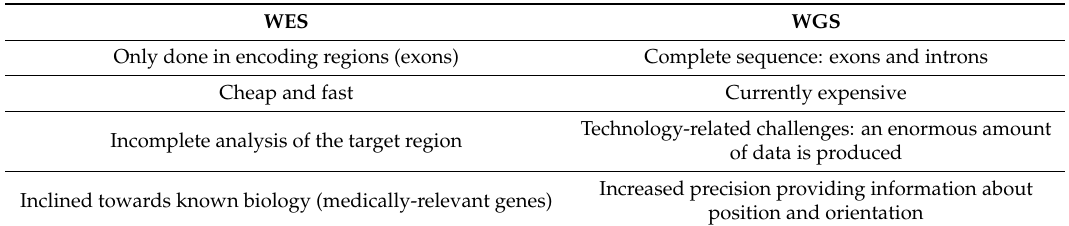
Table 1. Differences between whole-exome sequencing (WES) and